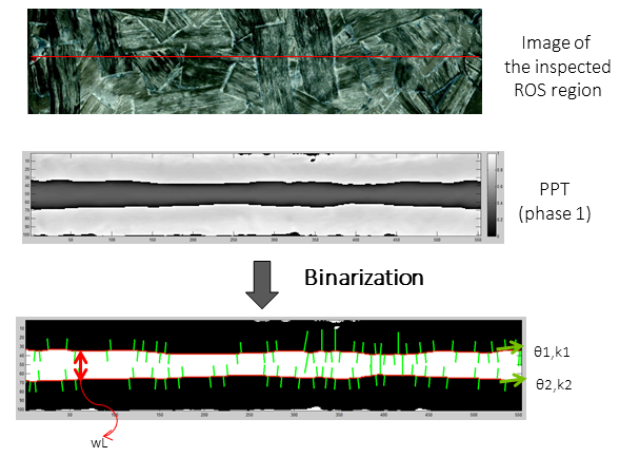
Figure 3. Summary of the process to obtain the envelope line, from where the features used in the Artificial Neural Network (ANN) are selected, from a Flying Laser Spot (FLS) inspection of a Randomly Oriented Strand (ROS) sample.